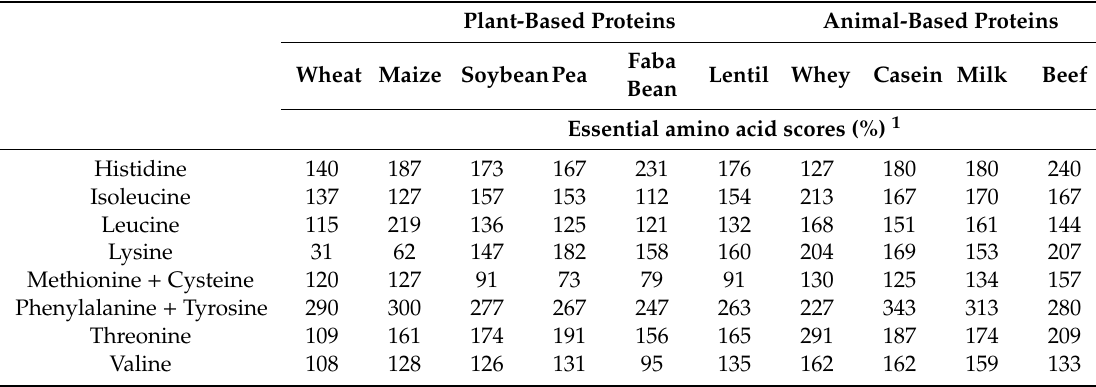
Table 2. Essential amino acid scores of animal- and plant-based protein sources; adapted from Laleg et al. [60] and Gorissen and Witard